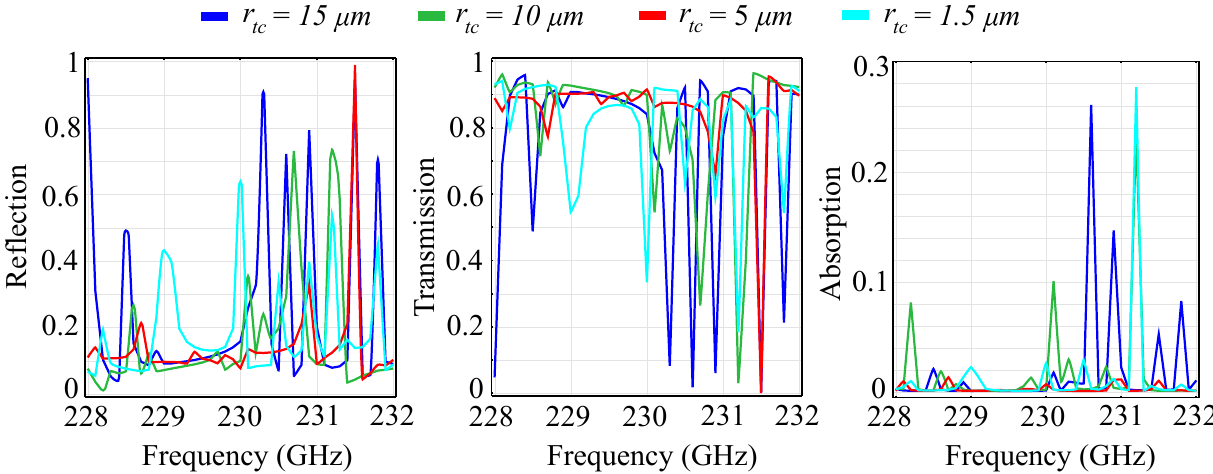
Figure 4. Simulated reflection, transmission, and absorption spectra for the silicon substrate configuration, in which the top radius of the inner cylinder ring r tc is varied between fixed values, in a transition from a cylinder to a cone